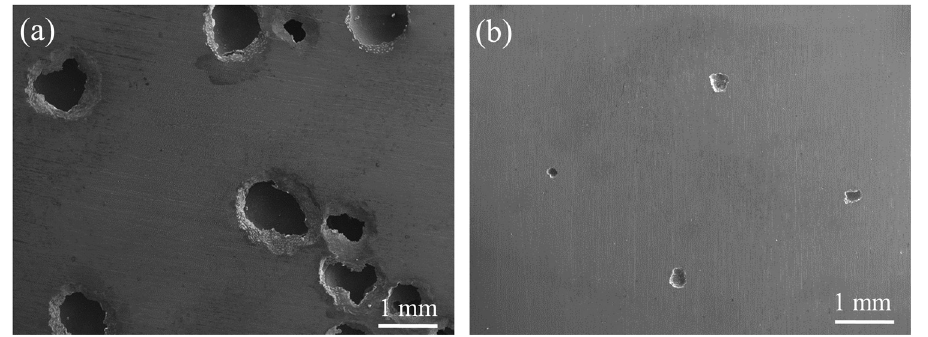
Figure 6: SEM morphology of pitting corrosion after potentiodynamic polarization. ( a ) FSS1 and ( b )